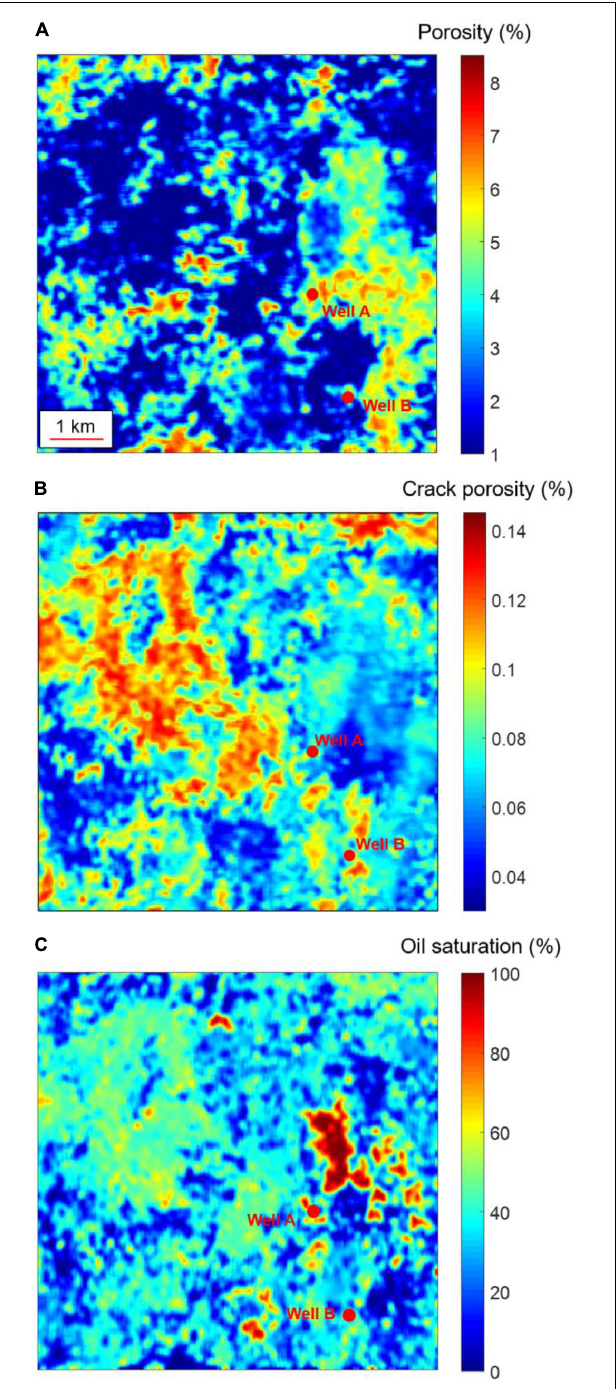
FIGURE 14 | Horizontal section of total porosity (A) , crack porosity (B) , and oil saturation (C) of the target layer.